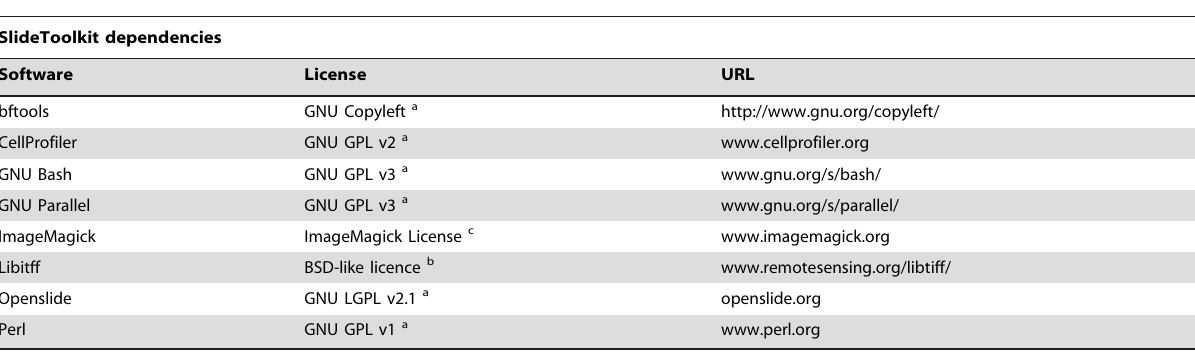
Table 2. SlideToolkit software dependencies, licenses and project